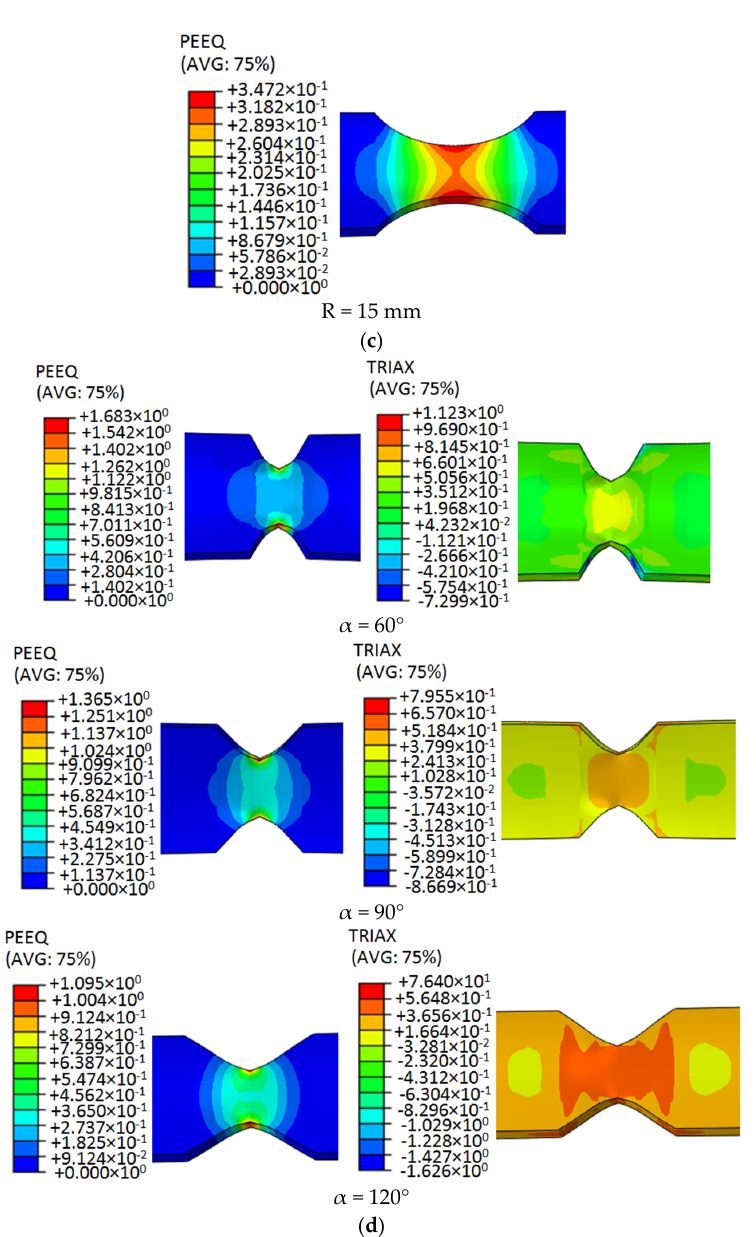
Figure 6. Equivalent strain and triaxiality stress program of the 6061 aluminum alloy samples. ( a ) Shear sample. ( b ) Circular arc tensile sample. ( c ) Arc-shaped notched tension sample. ( d ) V-shaped notched tensile sample.